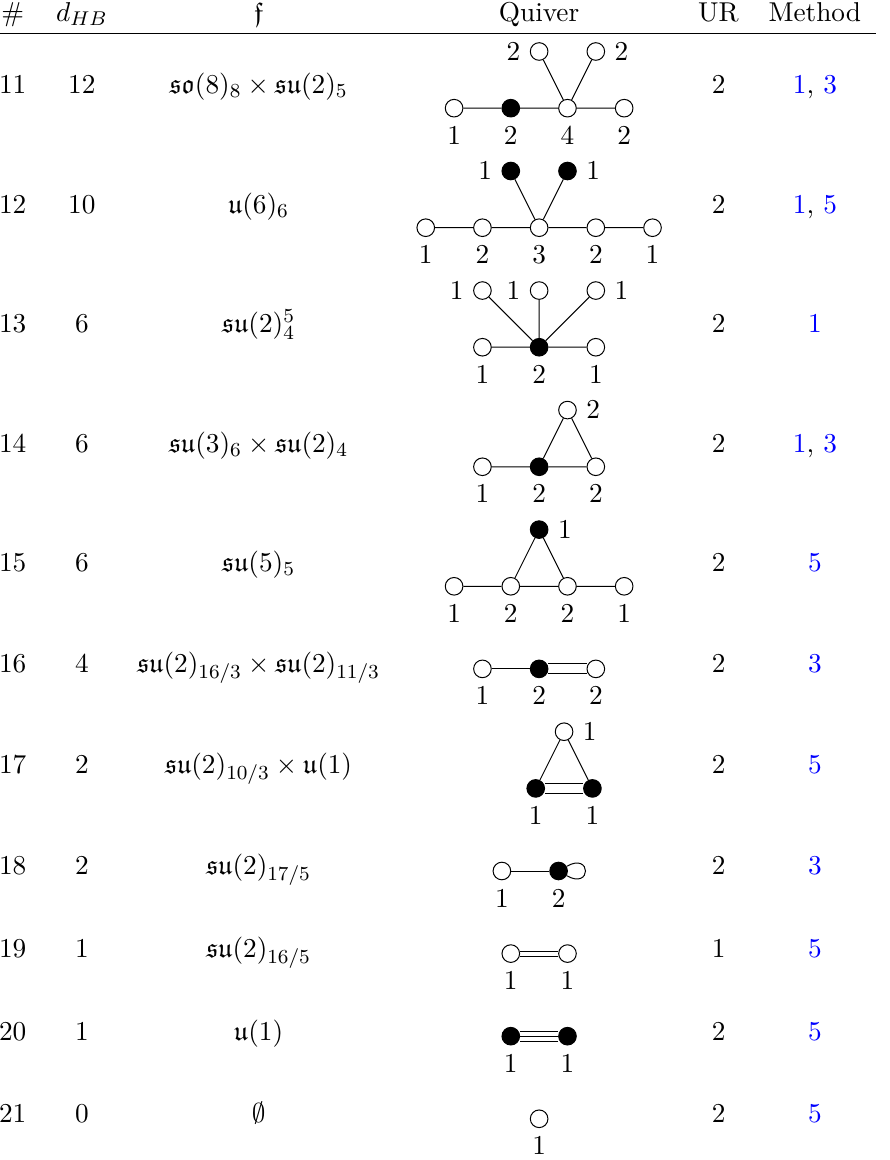
Table 2 . List of magnetic quivers